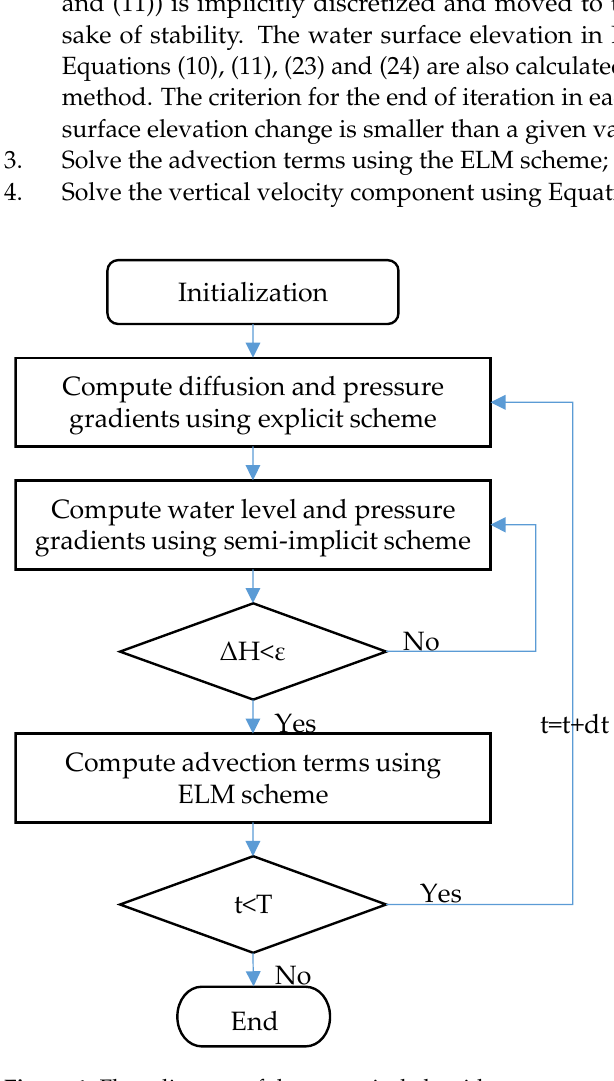
Figure 1. Flow diagram of the numerical algorithm.